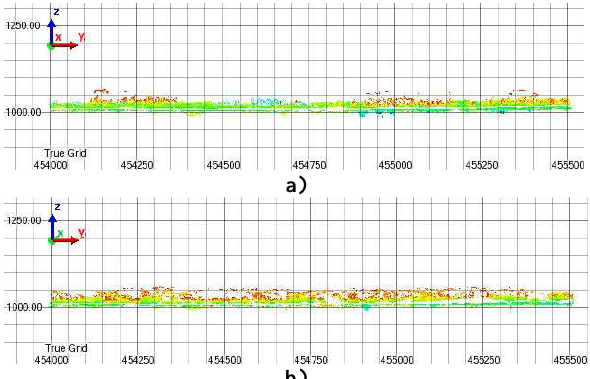
Figure 6. Change visualization from perspective on –y axis. a) The changes from 1951 to 1075, b) The changes from 1951 to